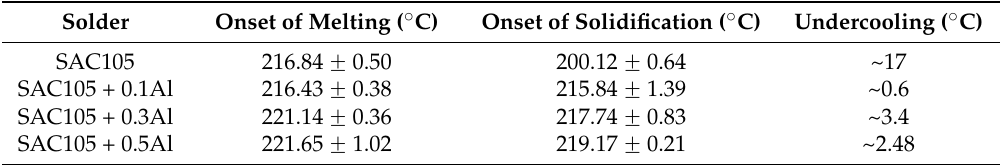
Table 1. Onset of melting, onset of solidification and undercooling of SAC105, SAC105 + 0.1Al, SAC105 + 0.3Al and SAC105 + 0.5Al.